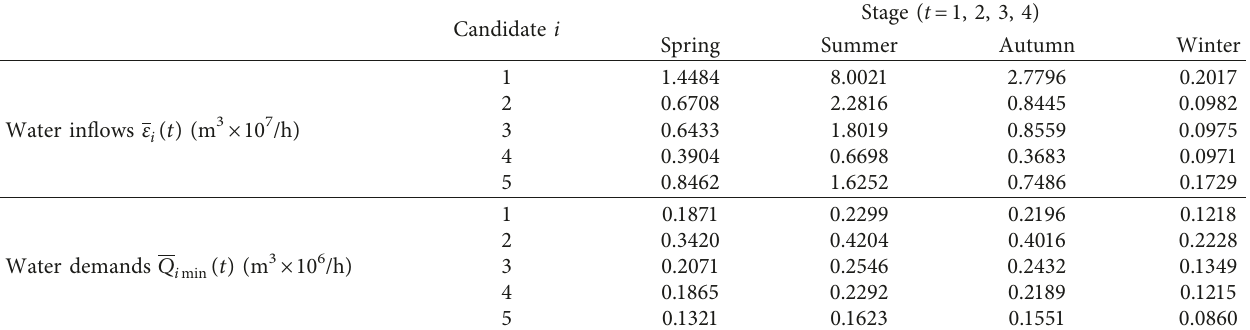
Figure 9: High, low-level water demand in each seasonal stage of each hydropower station Table 11: Predicted water inflows and demands in each seasonal stage.